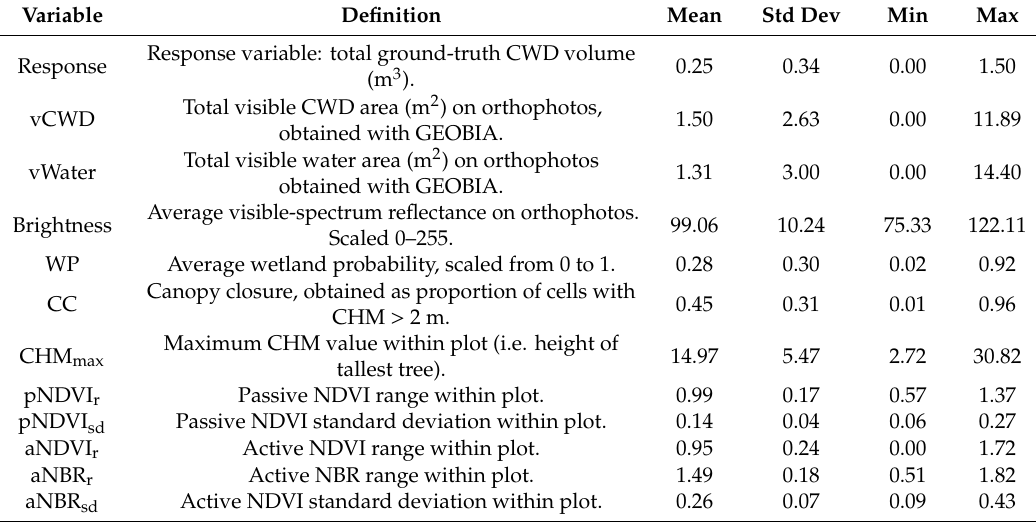
Table 2. Description and summary statistics of all variables used in model selection, each variable summarized with: mean, standard deviation (Std Dev), minimum (Min) and maximum